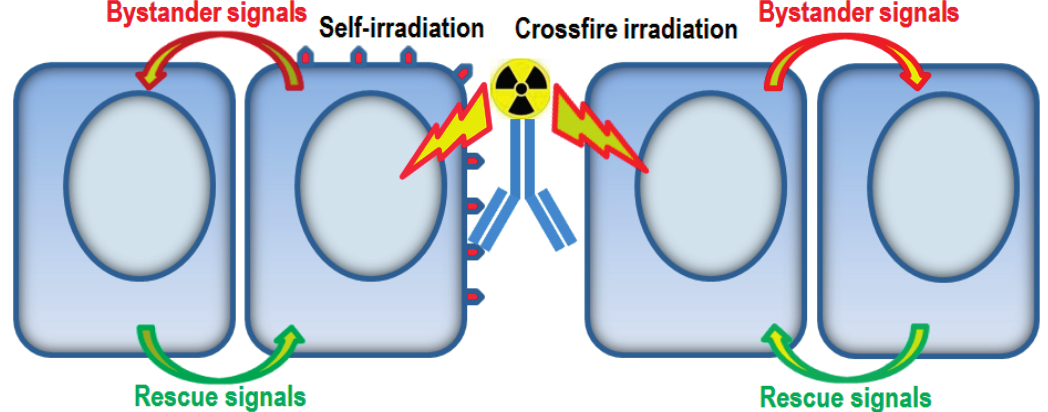
Figure 1. Schematic diagram showing the communication of bystander signals and rescue signals between unirradiated cells and irradiated cells, the latter having been irradiated by either self-irradiation (targeted cells) or crossfire irradiation (non-targeted cells) from the application of radioimmunotherapeutic